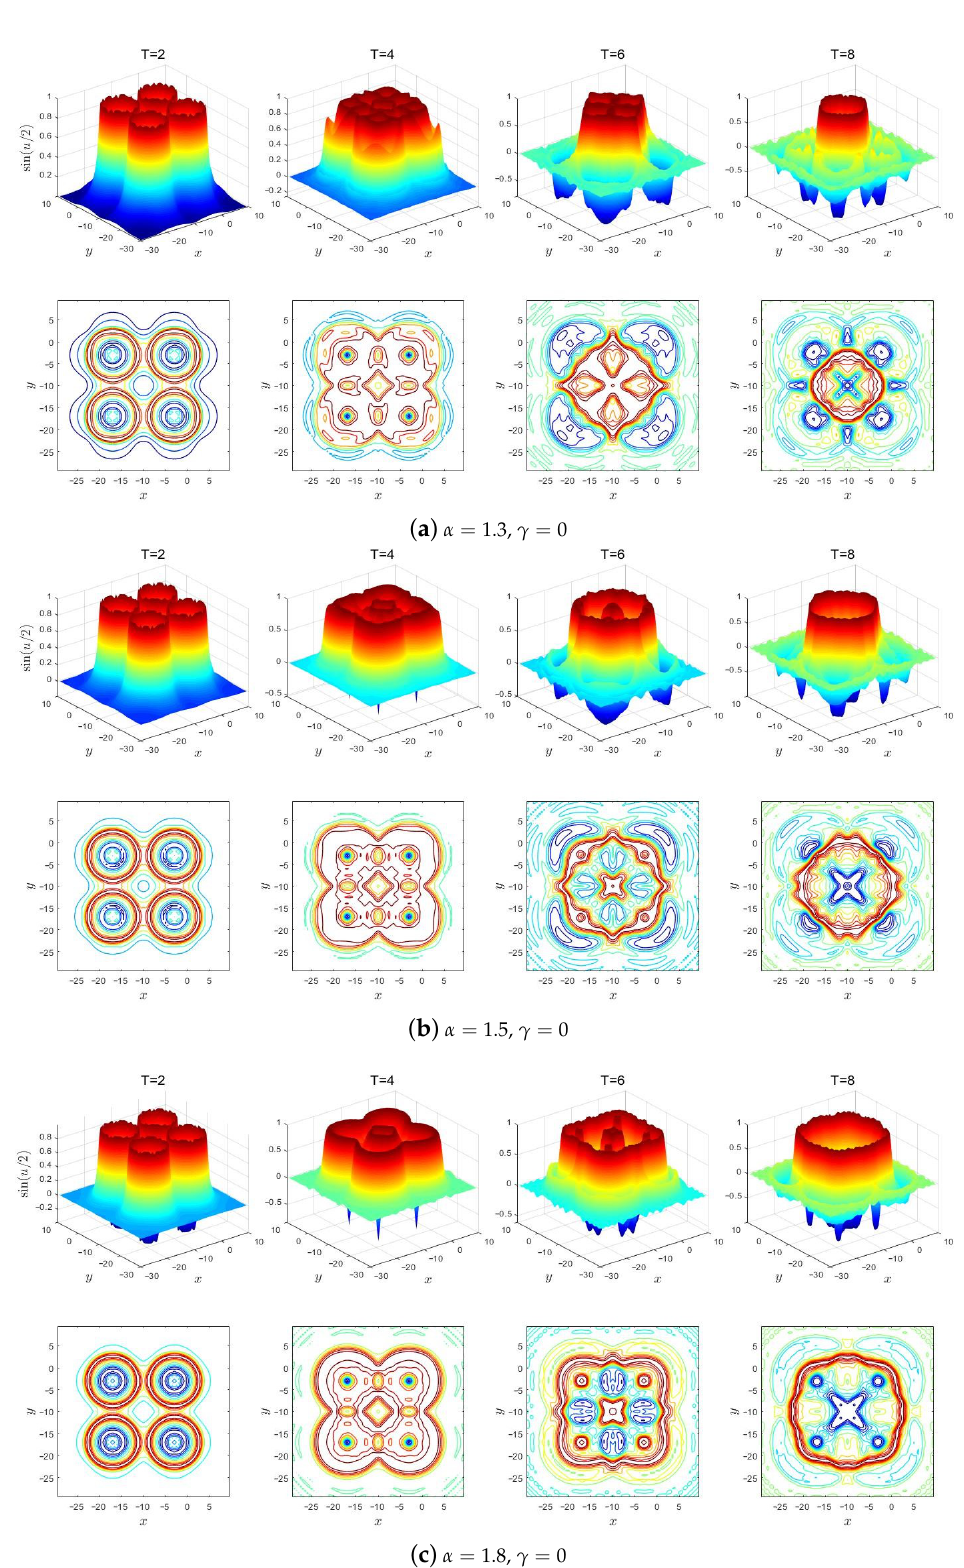
Figure 3. The numerical solutions in terms of sin ( u /2 ) and contour at different time T for different α with h = 1/2, τ =